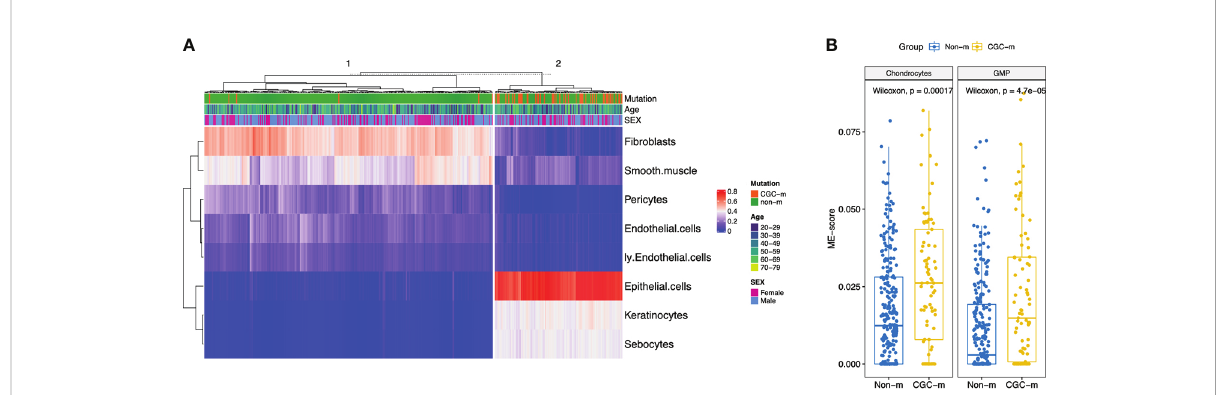
FIGURE 2 XCell scores of signi fi cantly different microenvironment cell-types, between CGC-m and non-m groups, identi fi ed using linear regression with age and gender as covariates. (A) Heatmap of signi fi cantly different ME scores in Esophagus previously implicated in cancer progression (B) Boxplots of signi fi cantly different ME scores in